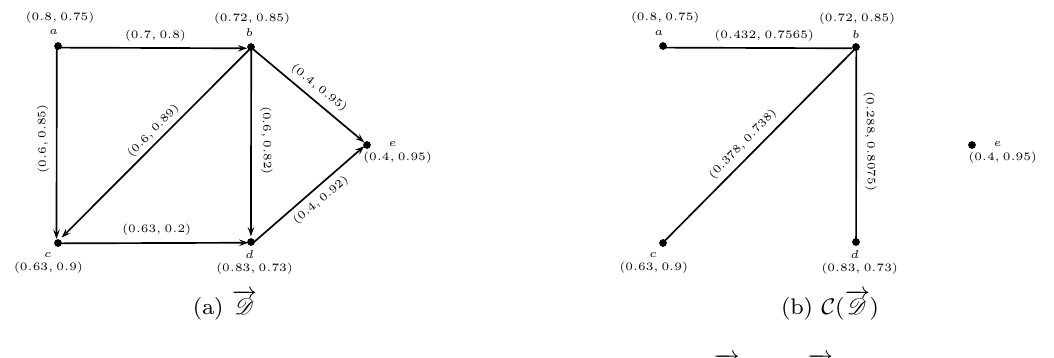
Figure 10. Competition graph of directed graph. ( a ) −→ D ; ( b )